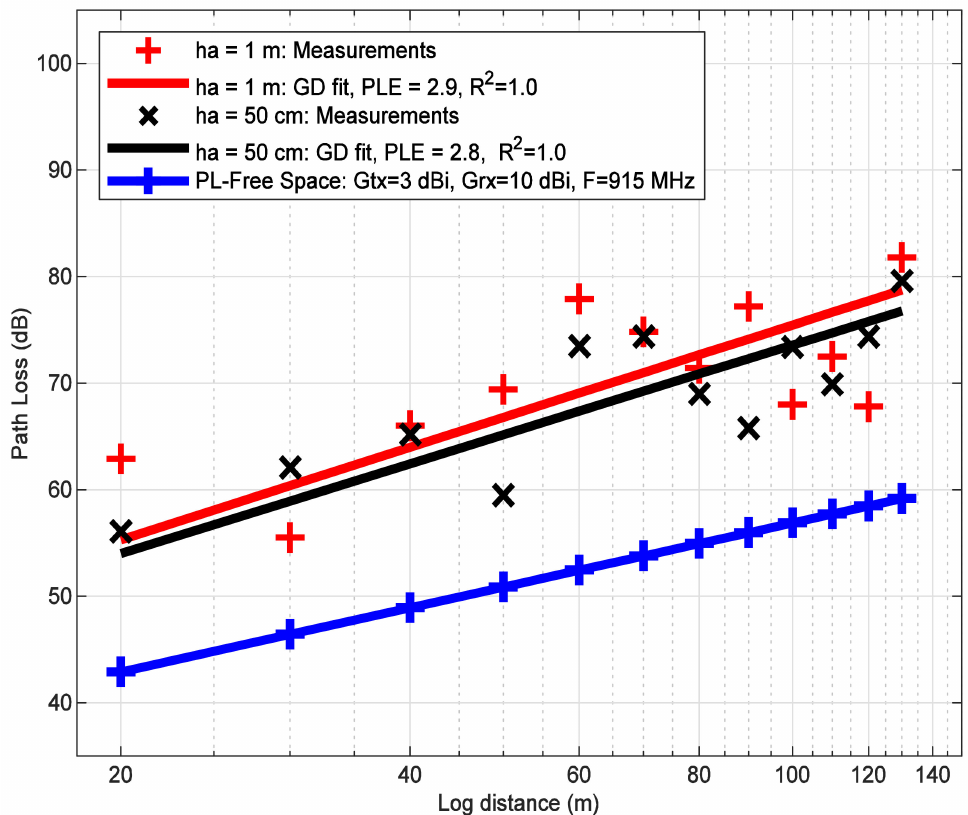
Figure 12. Obtaining the empirical path loss exponent (PLE) by linear regression. The gradient descent technique was used to get the PLE, in addition to computing the coefficient of determination at distances from 20 m to 130 m for both antenna heights (i.e., 1 m and 50 cm over the